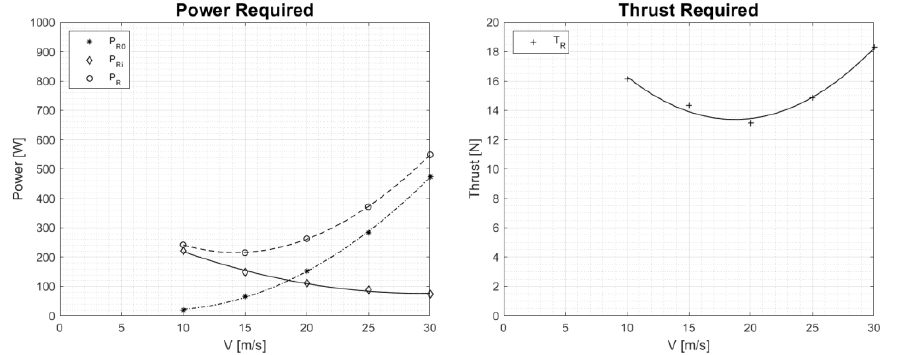
Figure 11. Power require ( left ) and thrust required ( right ) vs.